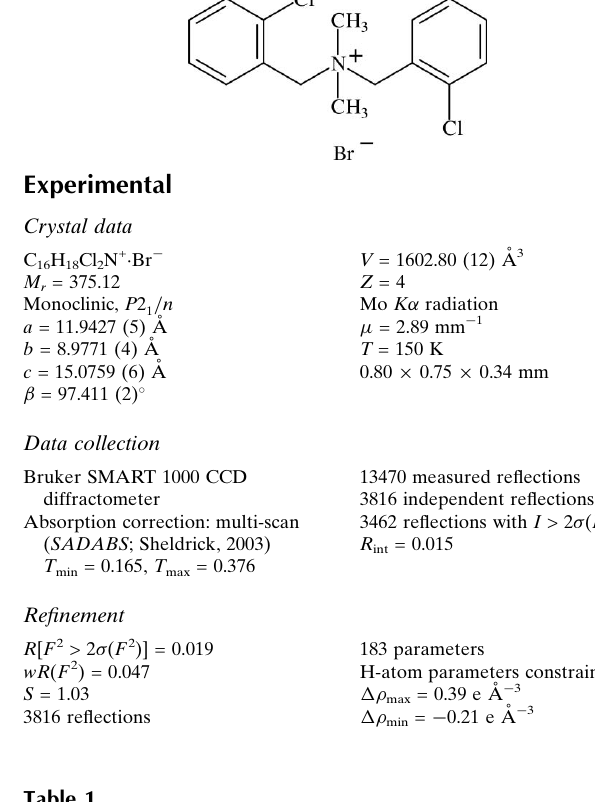
Hydrogen-bond geometry (A˚ , (cid:4)